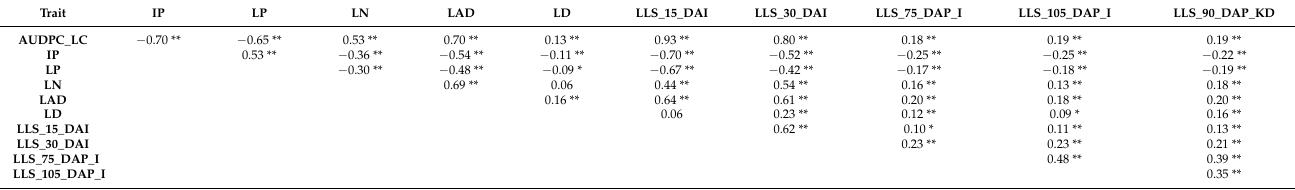
Table 5. Correlation among LLS resistance component across light chamber and disease screening nursery.